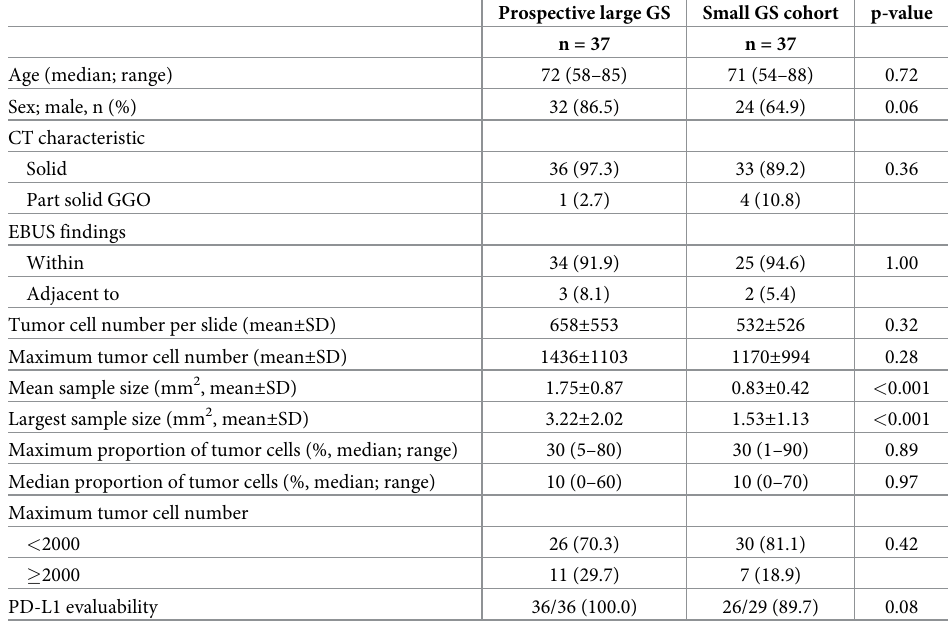
Table 3. Tumor cell counts and sample sizes between prospective large GS group and small GS